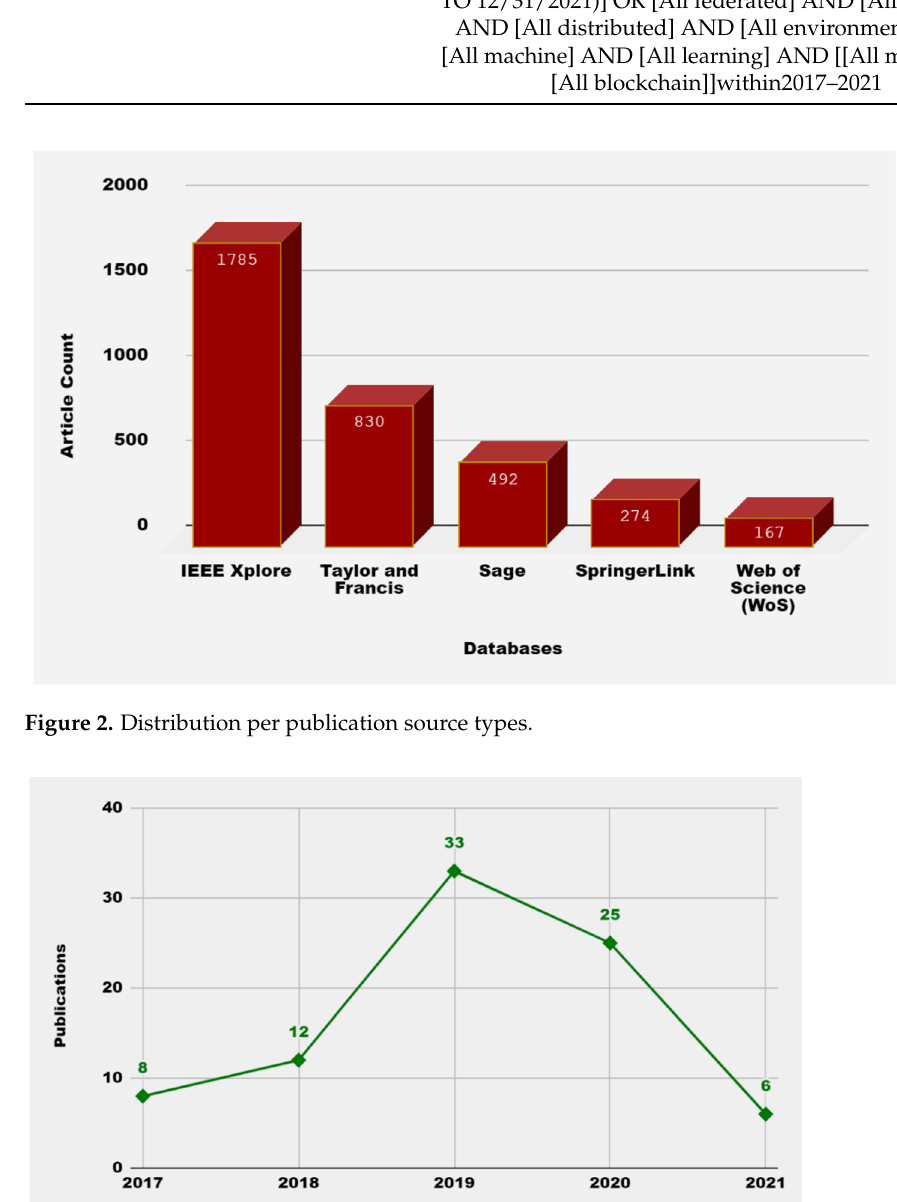
Figure 4. Articles that are pertinent to the study which was reviewed. 3.5. Selection Execution The goal of the search was to compile a preliminary list of research that will be eval- uated further. The papers were then examined to determine whether they were appropri- ate and could be utilized to answer the research questions formulated, which had a time frame of five years between 2017 and 2021 (Figures 1–5). Tables 4–10 summarize some of the studies chosen based on the formulated research questions. Figure 5. Categorization of primary articles based on a present review on FL.